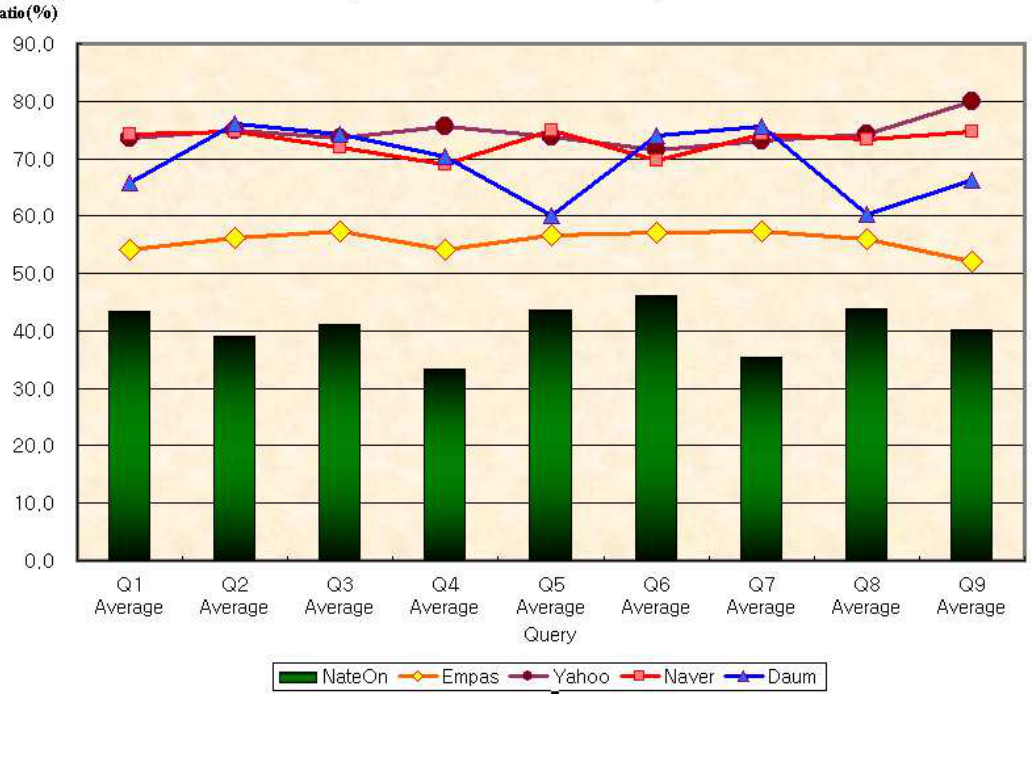
Figure 11. Matching ratio of Service Functional